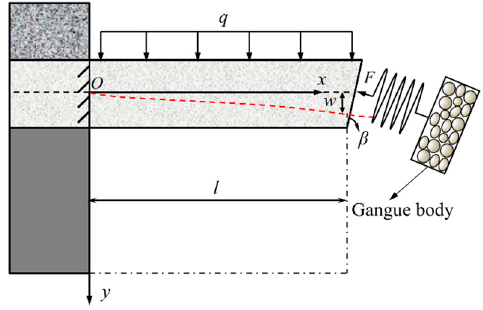
Figure 4. Mechanical model of the FRME approach.